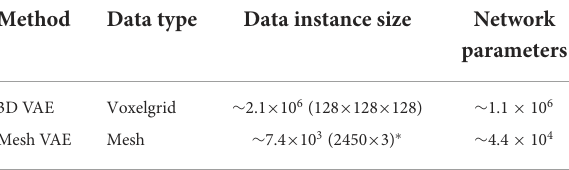
TABLE 2 Technical comparison of the mesh VAE and the 3D